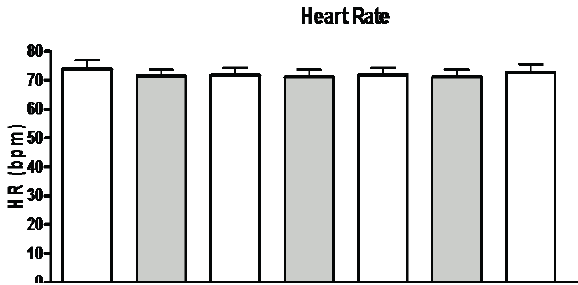
Figure 1 - Mean HR values obtained with the test group (white, n=11) and control group (gray, n=10). The HR values 0-5min, 5-10min and 10-15min refer to records made after application of the massage, which are compared to the same times of the CG, which remained lying down, but did not receive massage.ns = no signi fi cative. There was no statistically signi fi cant difference(s) be- tween the